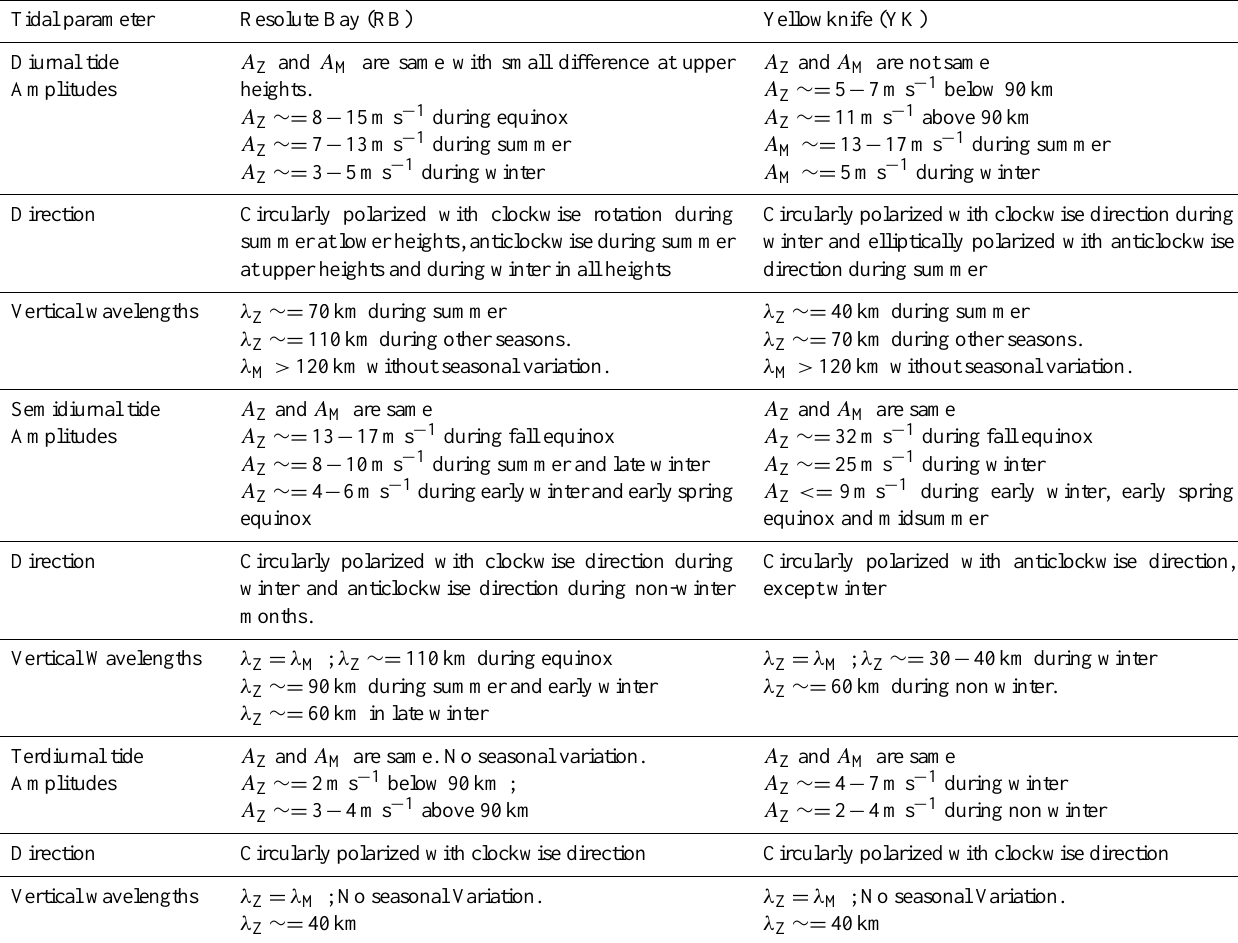
Circularly polarized with clockwise